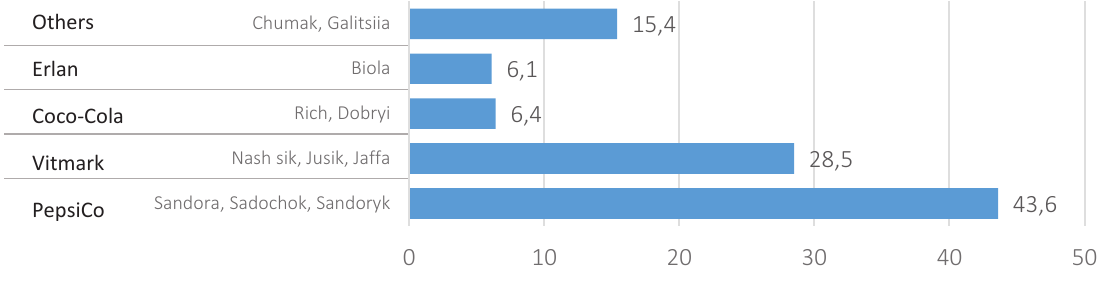
Source: Built by authors on the basis of MarketinG.vc